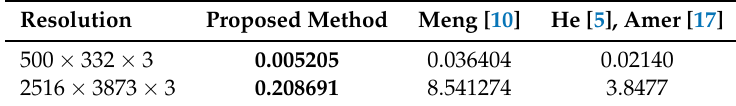
Table 1. Comparison of running time for the estimation of A s . In bold the best